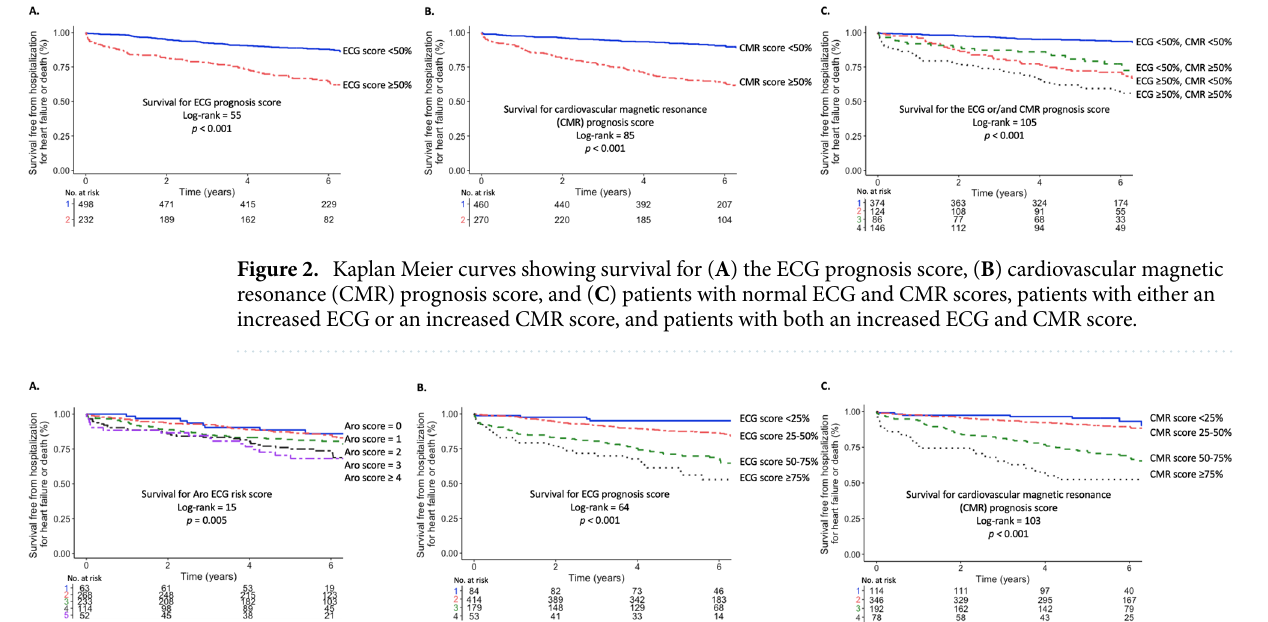
Figure 3. Kaplan Meier curves showing survival for ( A ) the Aro ECG risk score, ( B ) ECG prognosis score, and ( C ) cardiovascular magnetic resonance (CMR) prognosis